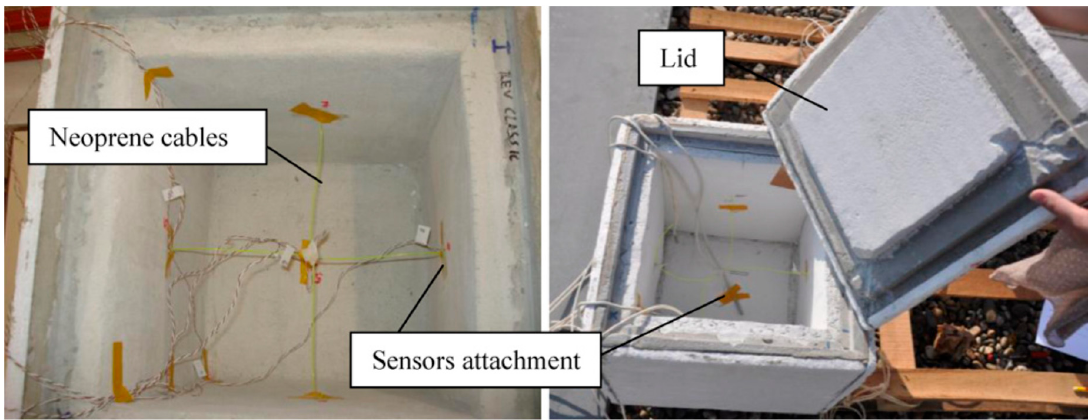
Figure 4. Distribution of the sensors inside the test cells.